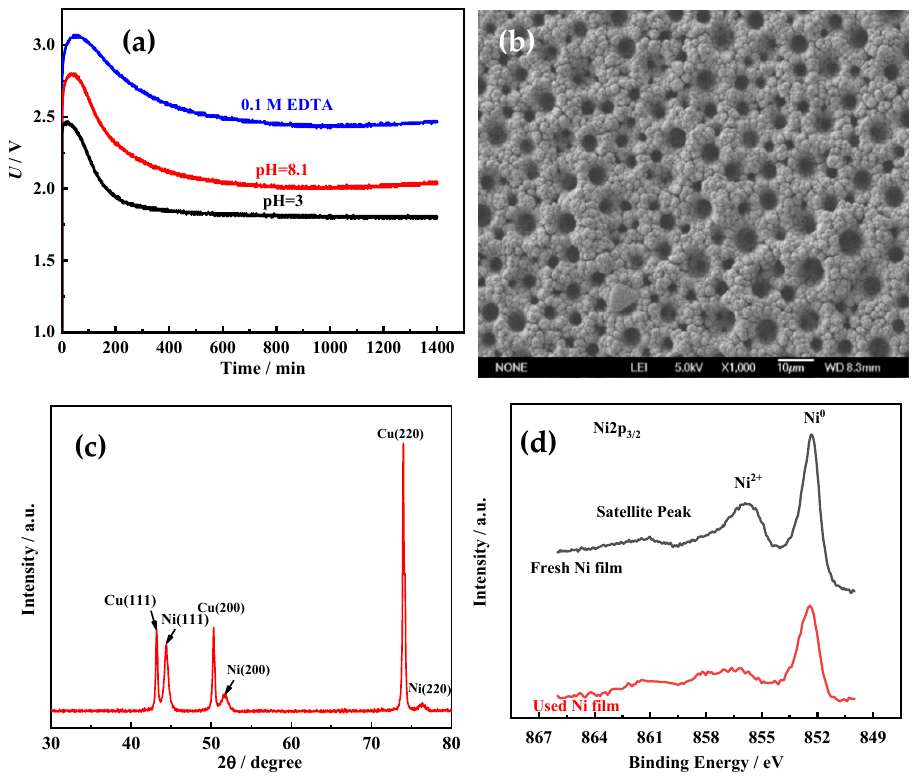
Figure 11. ( a ) The cell voltage (U)–time (t) curves of the Ni films at 100 mA cm − 2 . The SEM image ( b ) and XRD pattern ( c ) of the Ni film electrodeposited in acid solution (pH = 3) after the long-term electrolysis. ( d ) XPS spectra for the fresh Ni film electrodeposited in acid solution (pH = 3) and the Ni film after the long-term electrol ysis.